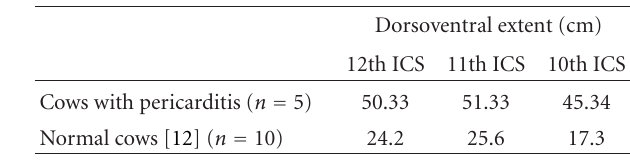
Table 2: Ultrasonographically determined mean dorsoventral extent of the liver in